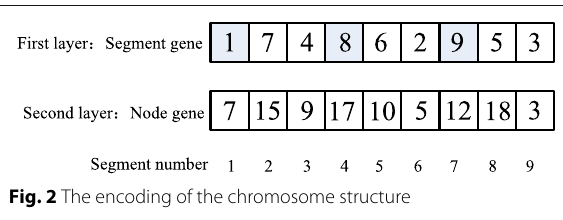
Fig. 2 The encoding of the chromosome